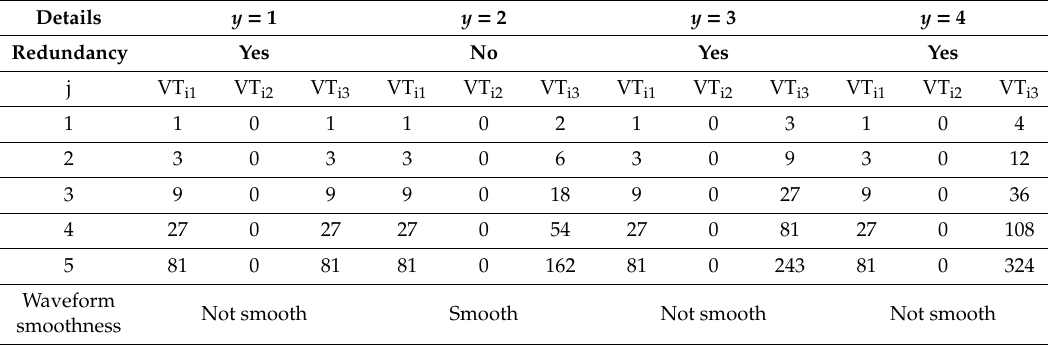
Table 2. Design procedure to find the value of ‘ y ’ in a Tri-State